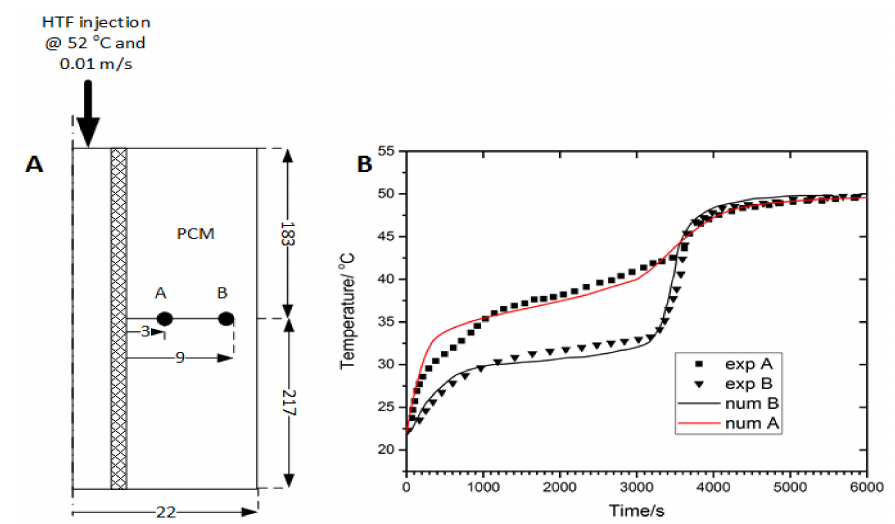
Figure 2. Model validation against experimental data from [41]: ( A ) Schematic of the experimental device and operating conditions. ( B ) Phase Change Material Temperature temporal profile at two selected location in the experimental